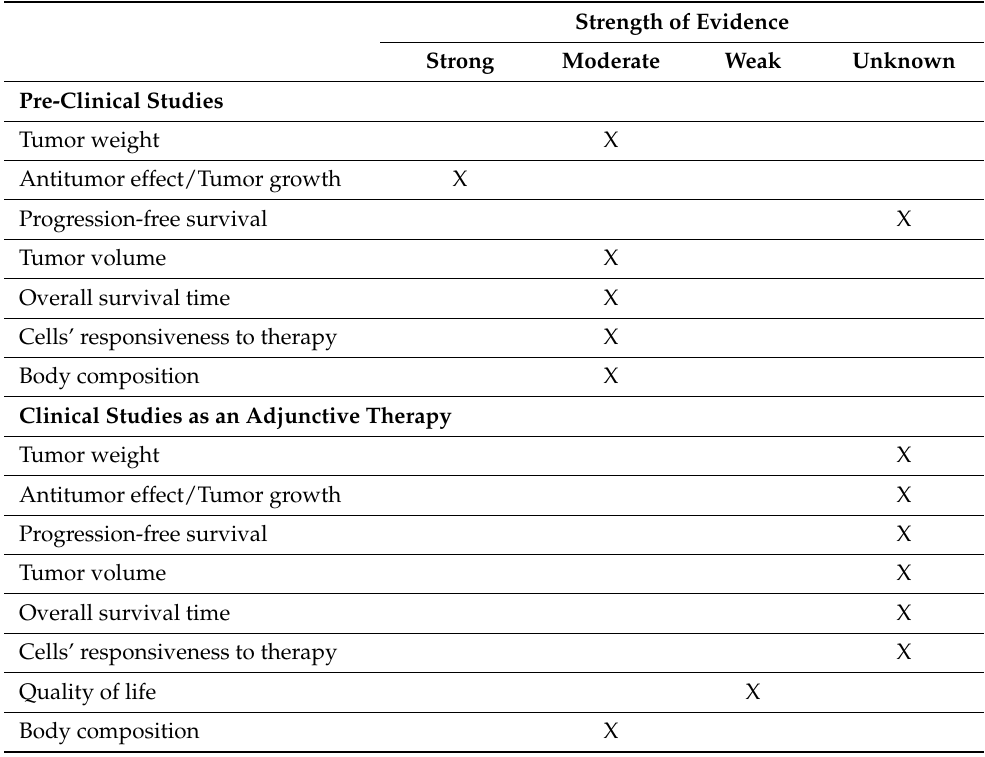
Table 2. Overview of Strength of Evidence for Beneficial Effects of the Ketogenic Diet for Cancer and Related Outcomes in Pre-Clinical and Clinical